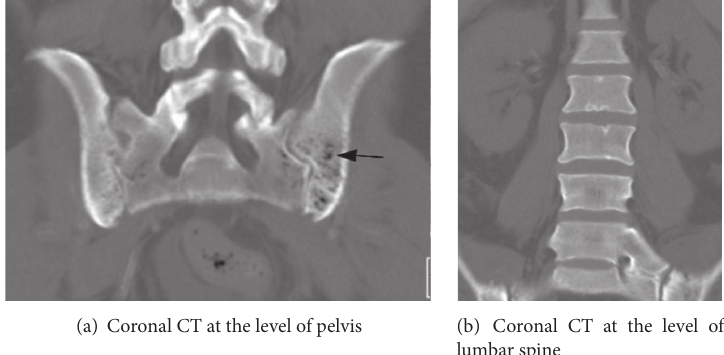
Figure 3: Coronal noncontrast CT three days prior to discharge/approximately 11 weeks after initial presentation shows (a) new foci of gas (arrow) within the sacrum and iliac bones, left greater than right. Findings in keeping with the preceding iliac bone marrow biopsy showing extensive bone necrosis. (b) Spine at this point still remains normal in CT appearance.